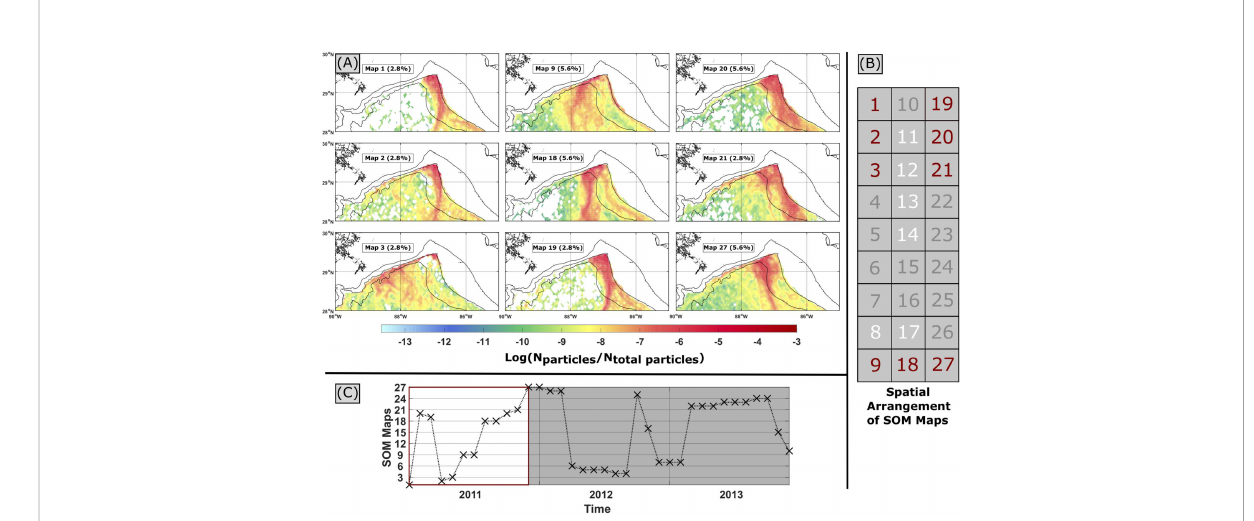
FIGURE 8 (A) SOM maps presenting virtual particle density in each grid cell, normalized by the total number of virtual particles in the domain, for 2011, represented on a log scale. Isobaths are shown in black. (B) The user speci fi ed spatial arrangement of SOM maps for the analysis, where the white, red, and gray numbers represent SOM maps that never occur, occur in 2011, and do not occur in 2011, respectively. (C) The BMU for each month, where the white area signi fi es